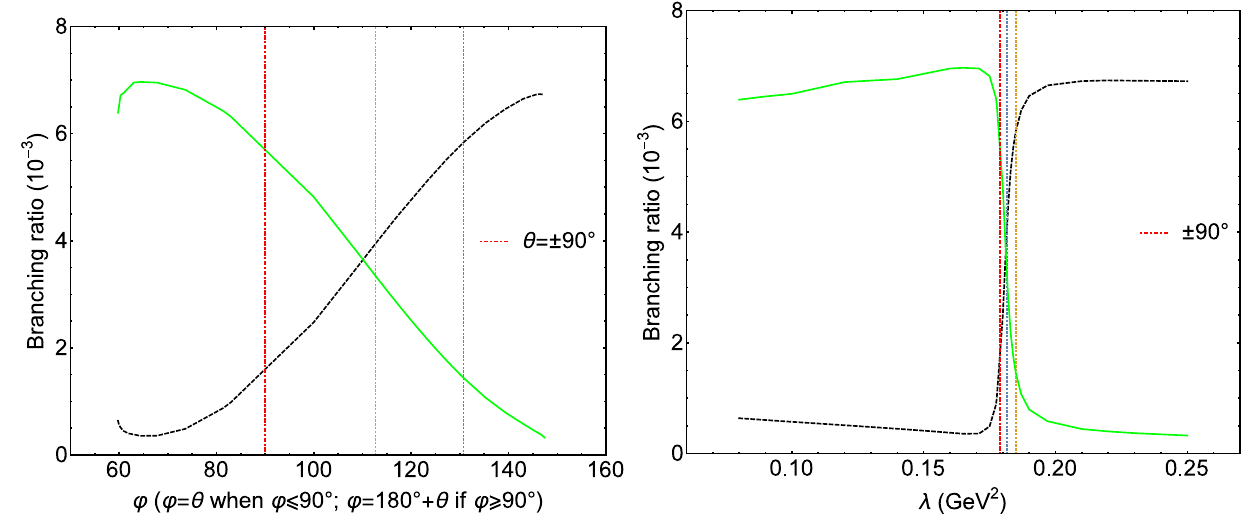
(cid:4)ν (cid:4) ) (green line). Between the blue and orange dotted lines is 1